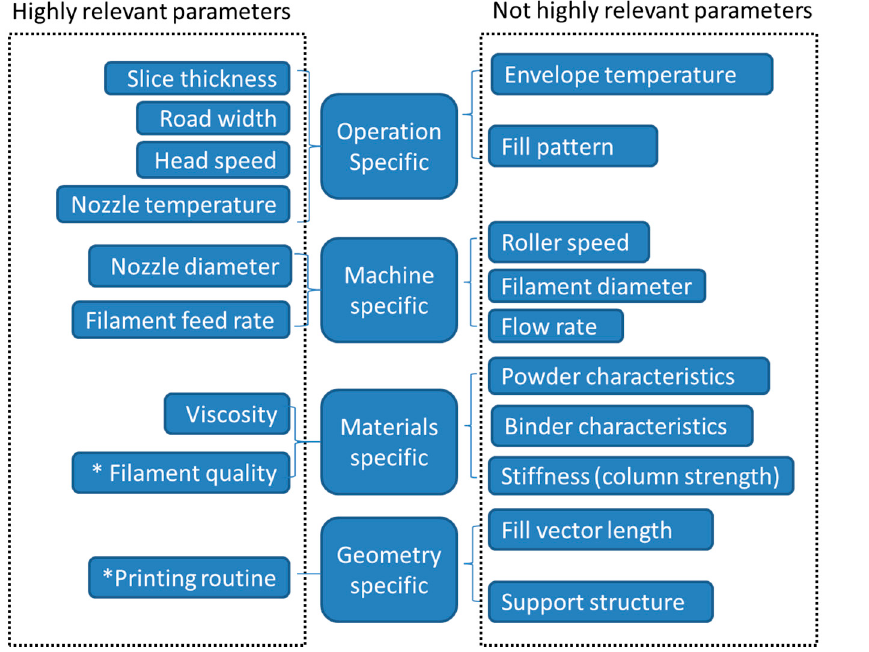
Figure 2. Schematic diagram of parameters that have e ff ects on small PEEK parts made from FDM [27].